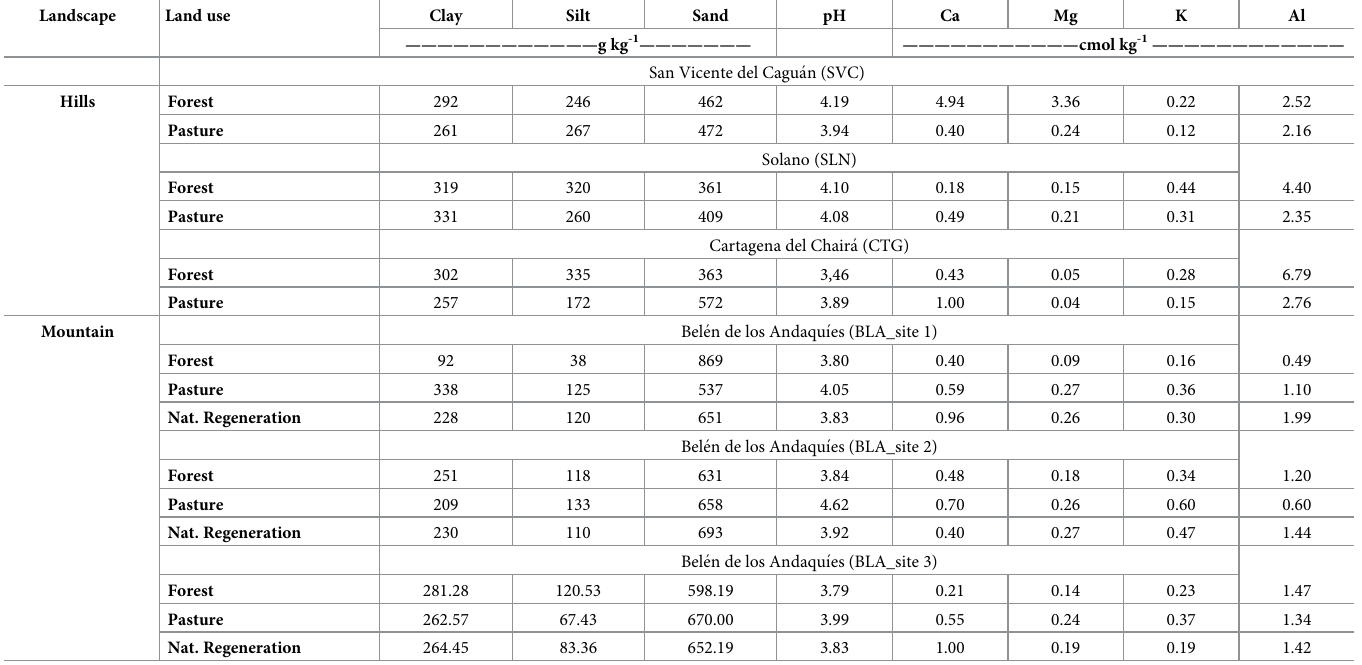
Table 1. Soil granulometric fractions and chemical attributes in the study sites.